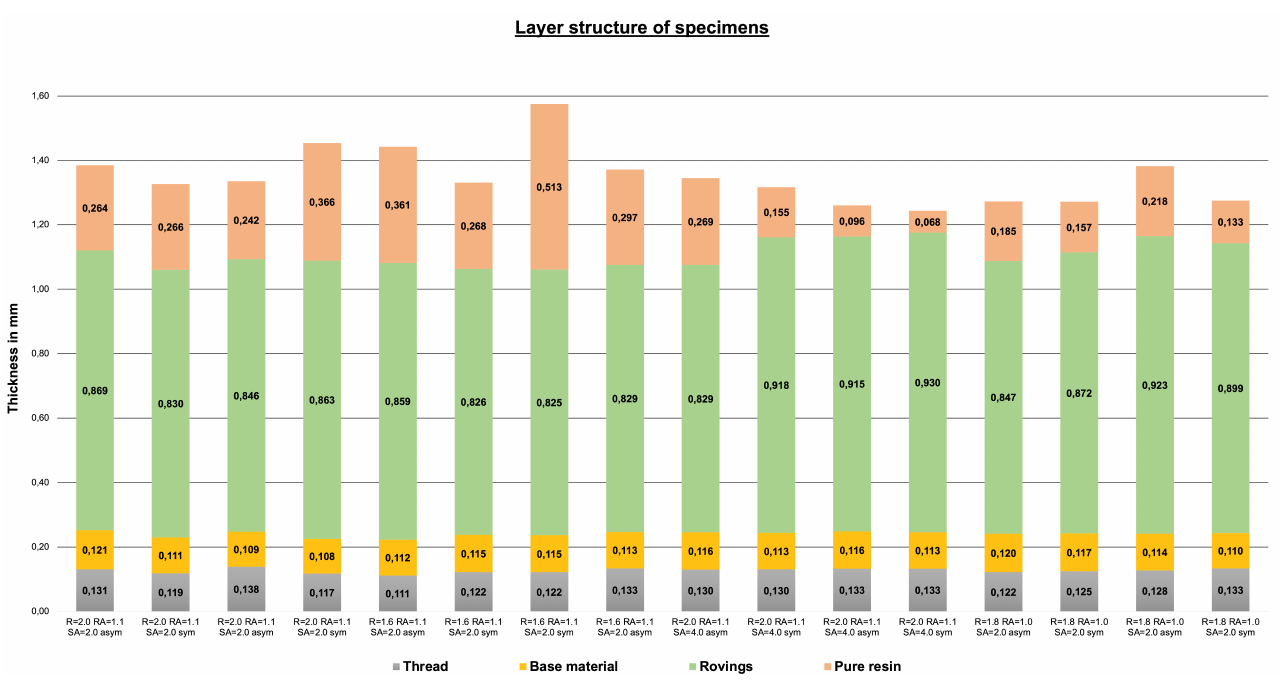
Figure 10. Thicknesses of sewing thread layer, base material, roving layer, and resin layer within each TFP